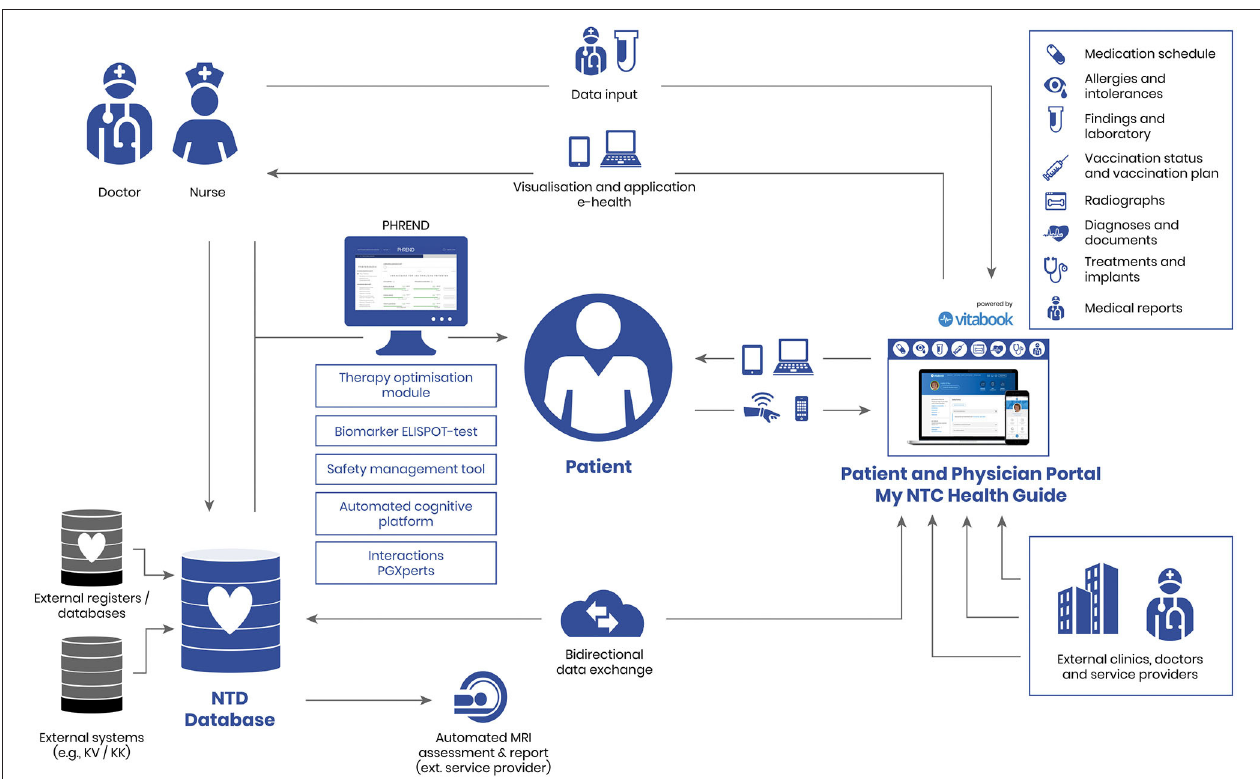
FIGURE 2 | DESTINY (DatabasE-assiSted Therapy decIsioN support